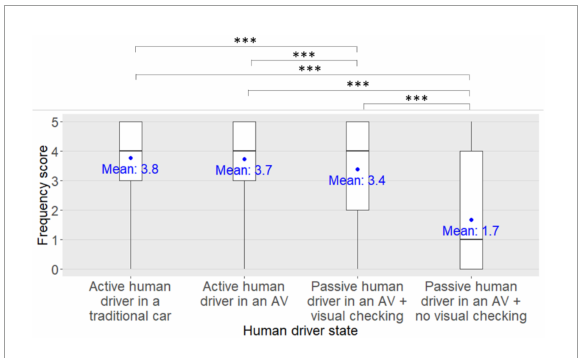
FIGURE7 Main effect of the human driver state on the kick scooter users’ frequency scores for seeking eye contact with the driver of the approaching car in order to express their willingness to cross to the human driver. ***: pFDR <